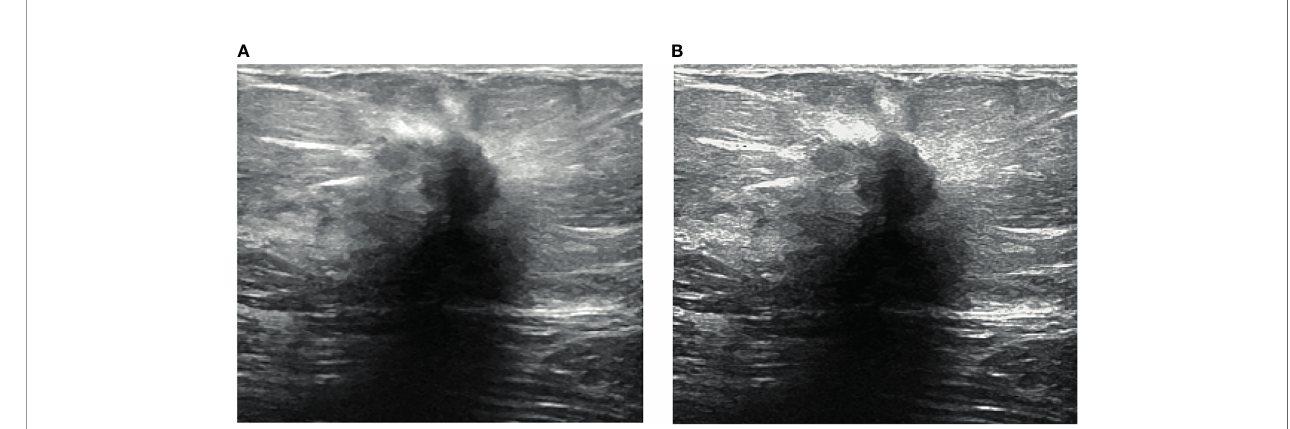
FIGURE 2 | Processing results. (A) Ultrasound image and (B) enhanced ultrasound image.